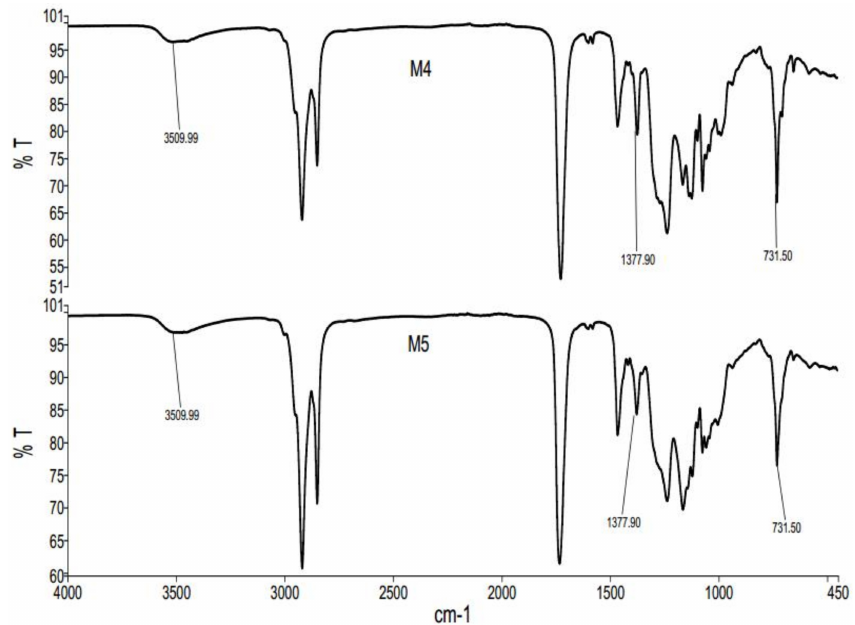
Figure 3. FTIR spectra of the M4 and the M5